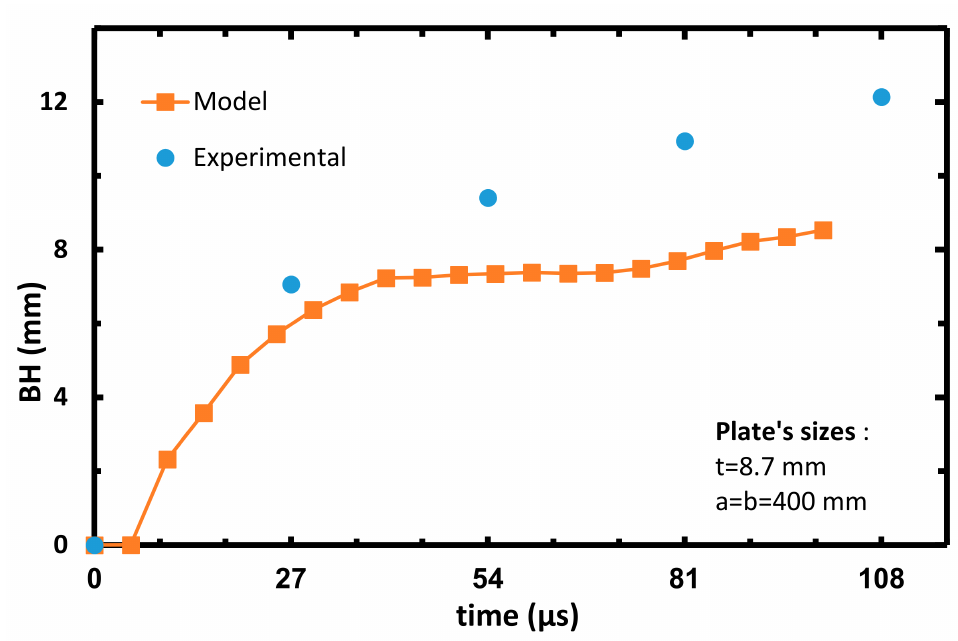
Figure 15. Plate’s bulge height vs. time of the calibrated model, Vinitial = 530